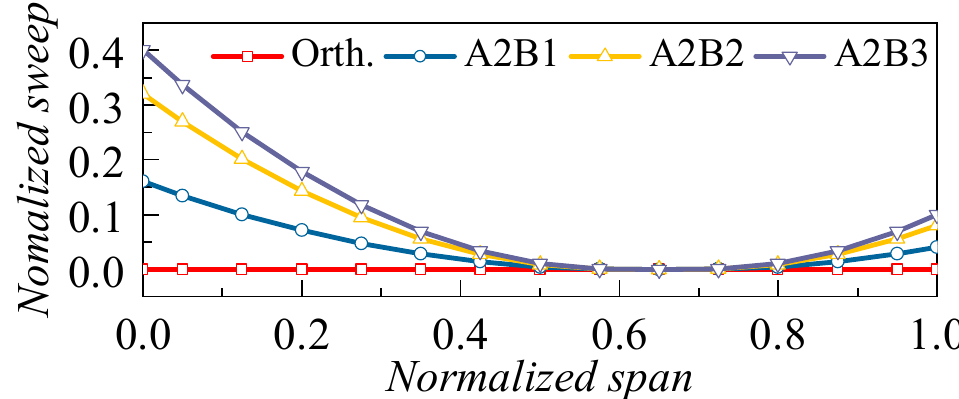
Figure 9. Radial distribution of blade sweep for the cases with different sweep angles.